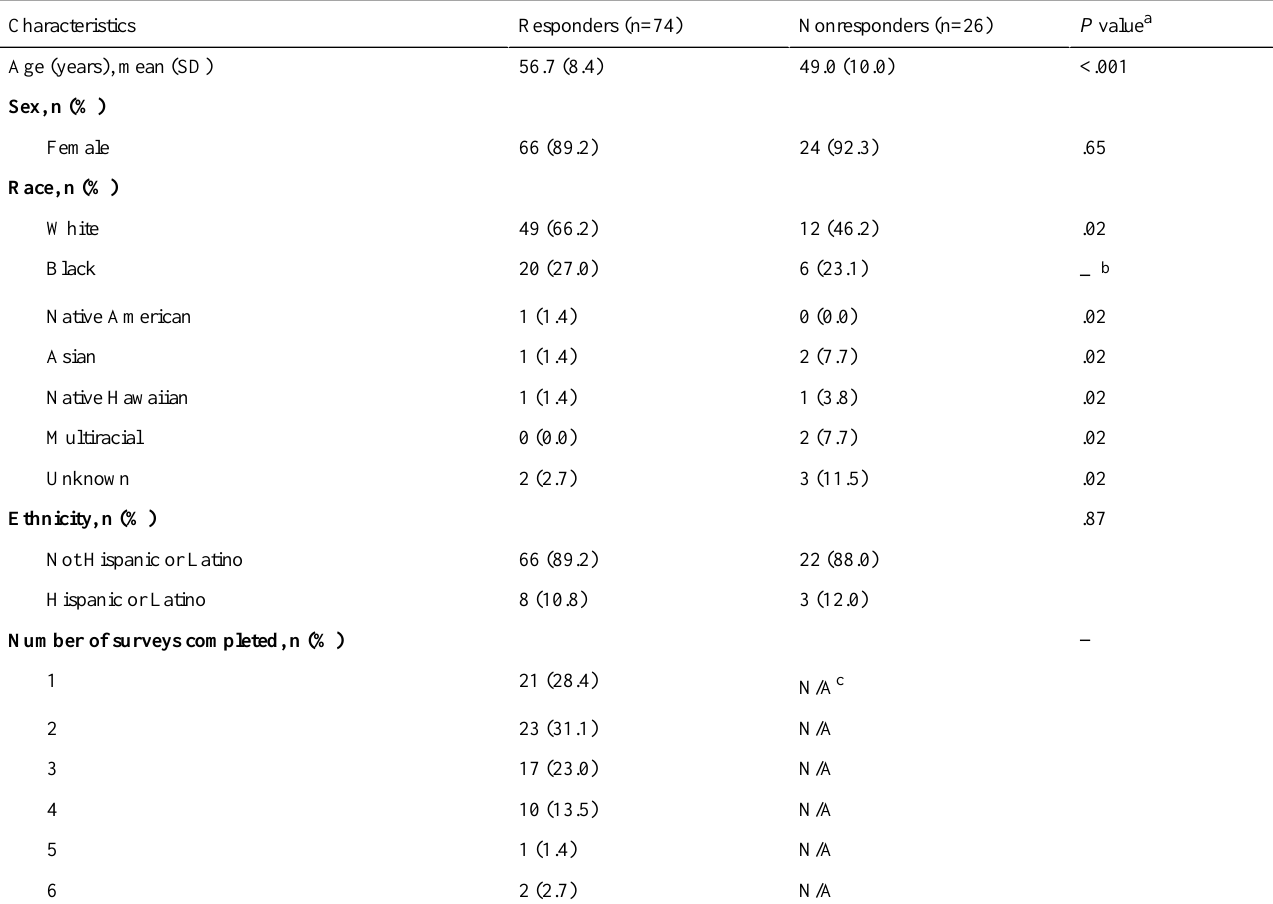
Table 1. Participant characteristics.